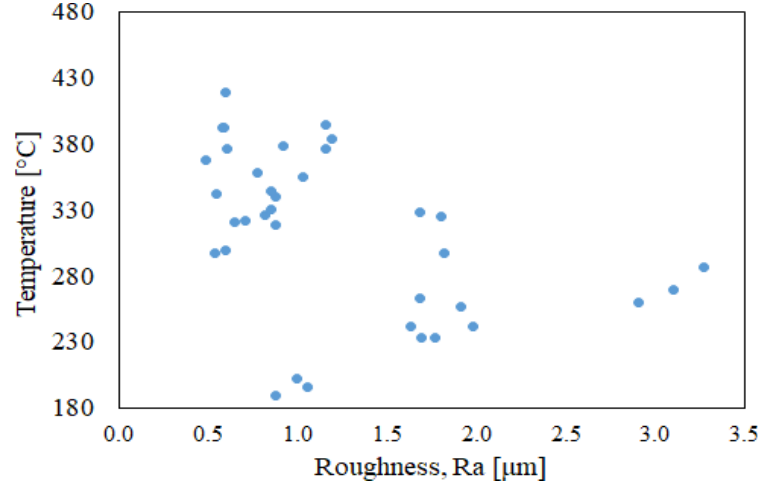
Figure 10. Scatter plot of the cutting temperature vs. surface roughness.